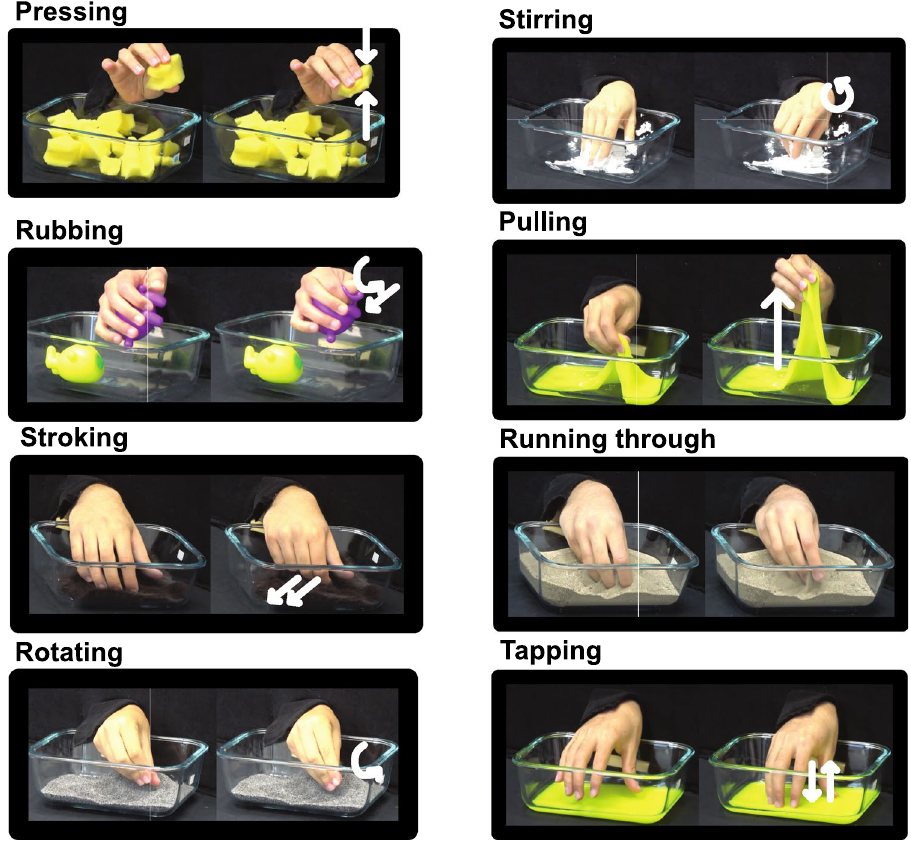
Figure 1. Screenshots illustrating the 8 EPs proposed in this study. Arrows show the direction of hand movements: pressing sponge pieces, rubbing stress balls, stroking fur, rotating poppy seeds, stirring hand cream, pulling slime, running the fingers through sand, and tapping fingertips onto